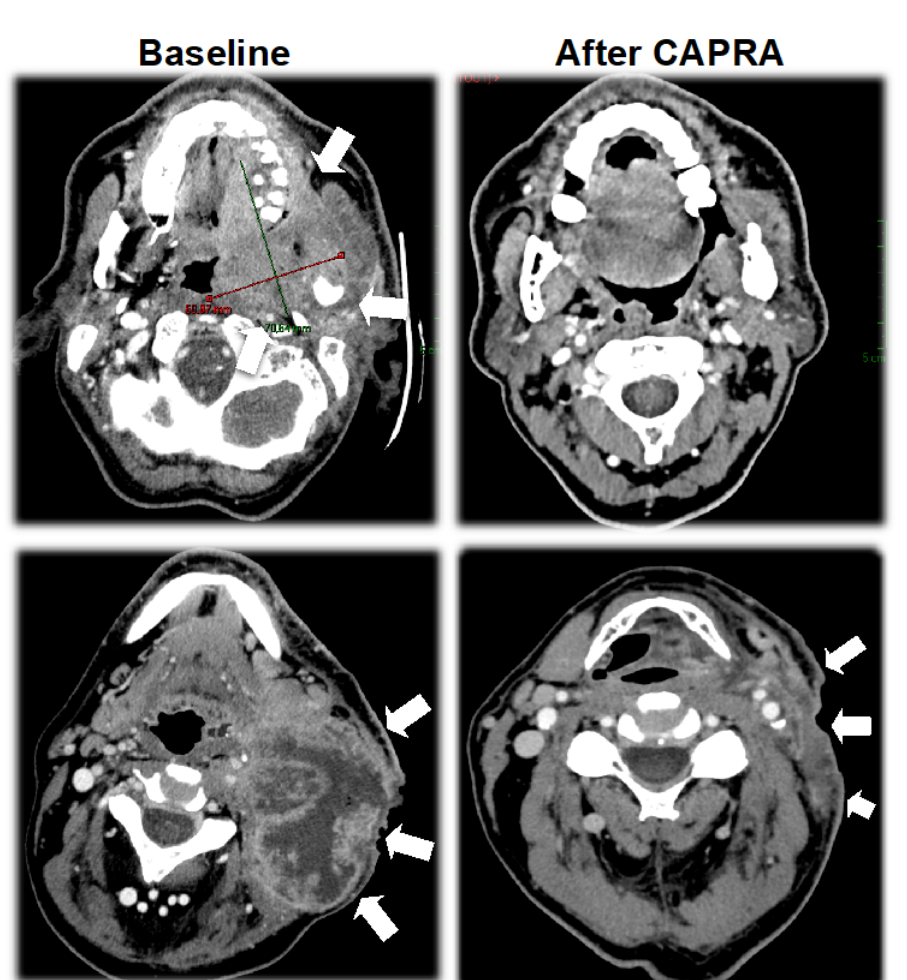
Figure 3. Imaging evolution at baseline and after 9 cycles of induction treatment showing major response in a case of oropharyngeal squamous cell carcinoma (upper panels) and another case of N3 necrotic cervical node involvement of hypopharyngeal squamous cell carcinoma (lower panels). The white arrows show the tumor localization on each